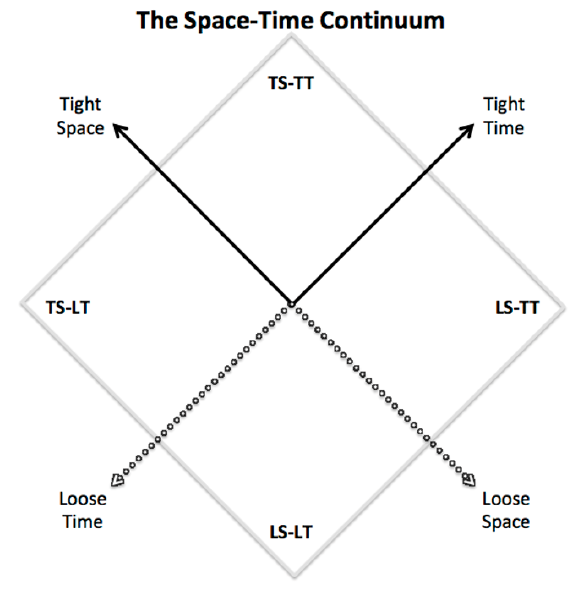
Figure 2. The four quadrants of the Space-Time Continuum.